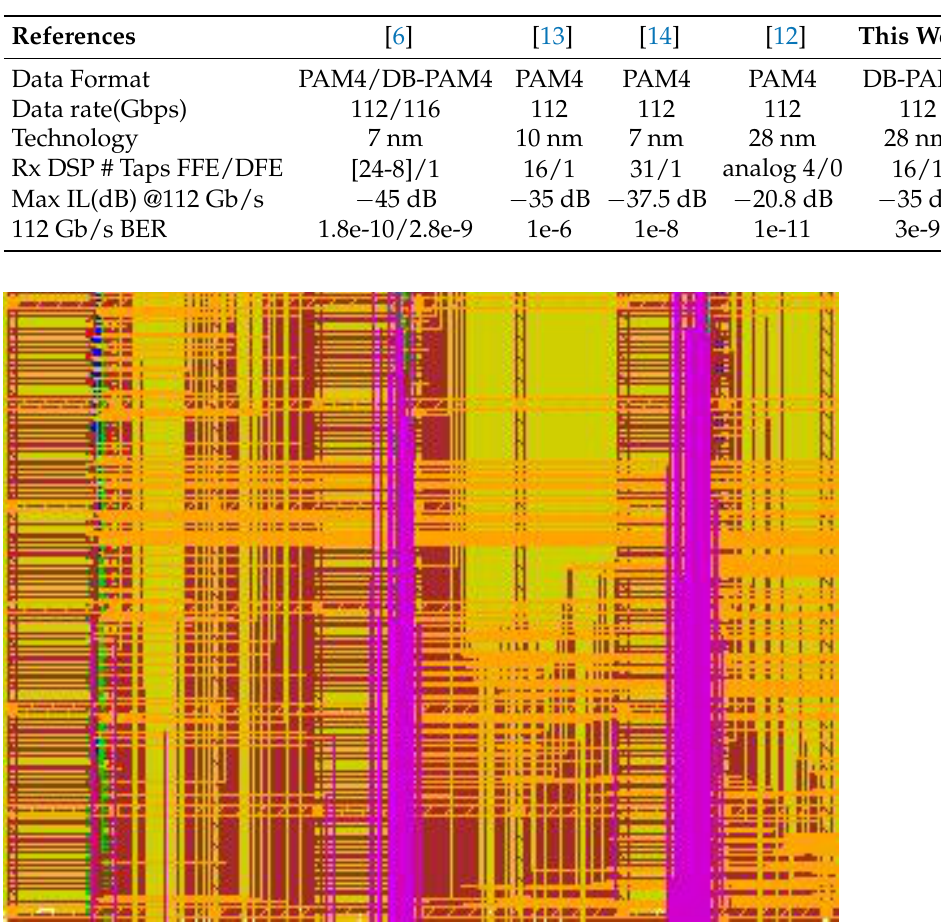
Figure 13. The eye diagram in 112 Gb/s − 35 dB. Table 1. Performance comparison.